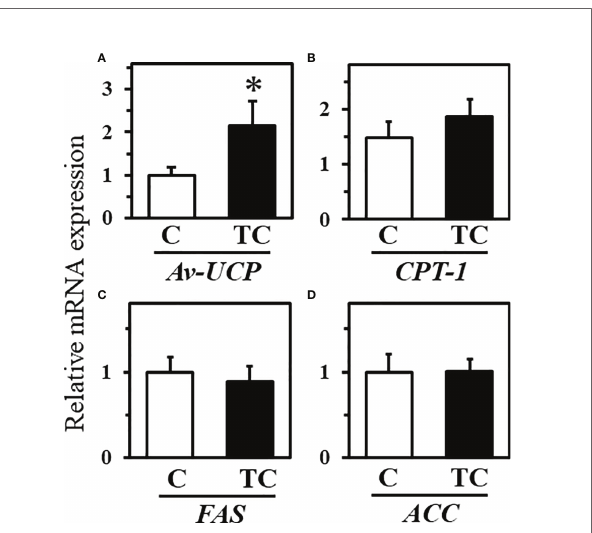
FIGURE 5 | Gene expression levels in liver tissue after low temperature exposure in experiment 2 (mean ± SEM). (A) shows gene expression of uncoupling protein (UCP), (B) shows gene expression of carnitine palmitoytransferase 1 (CPT-1), (C) shows gene expression of fatty acid synthase (FAS), (D) shows gene expression of acetyl-CoA carboxylase (ACC). The number of chicks in each group was n = 8. * indicates a signi fi cant difference between groups.